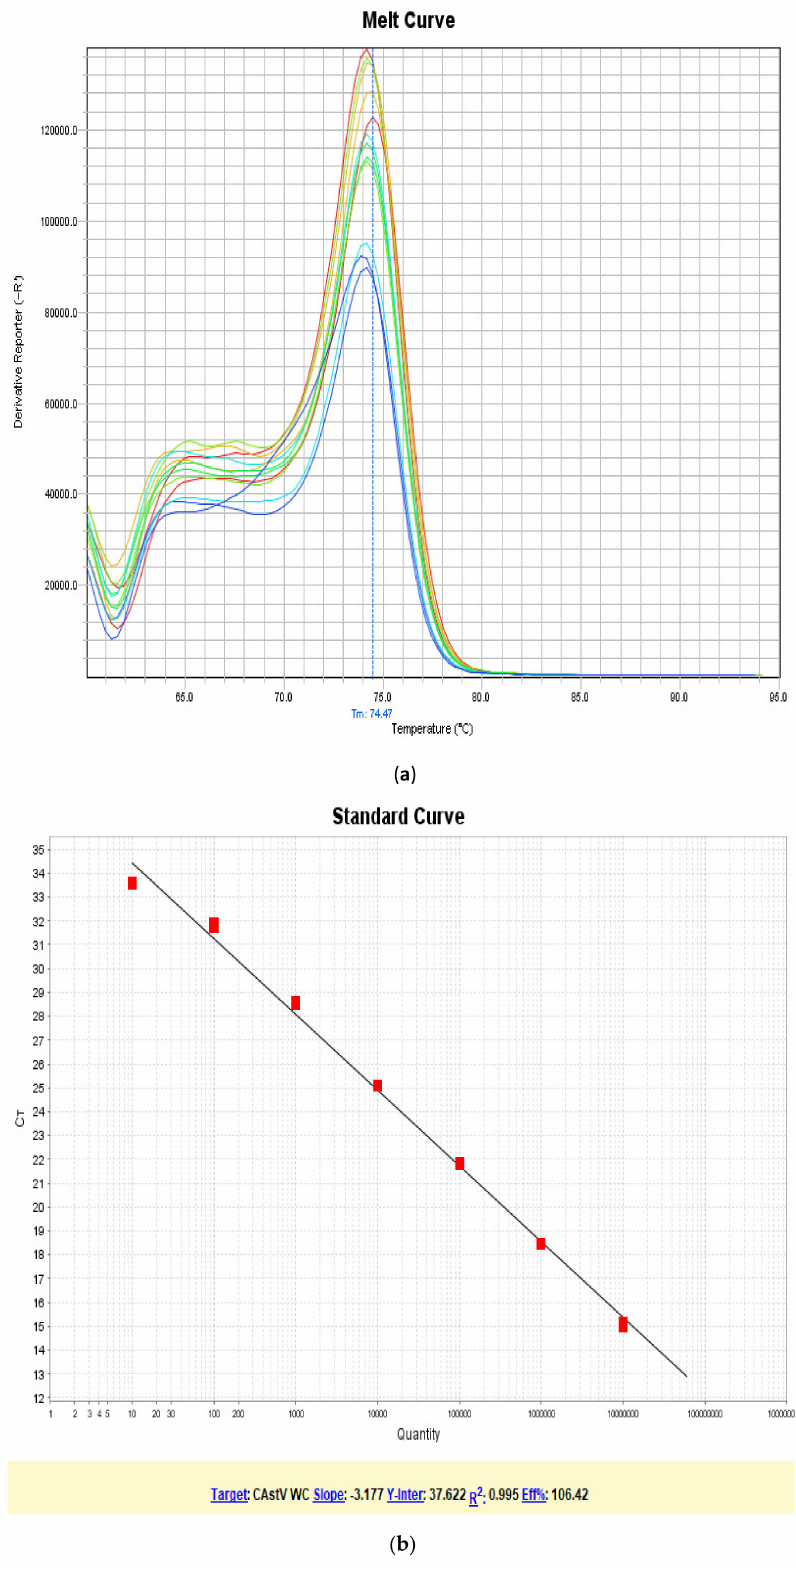
Figure 3. Melting ( a ) and e ffi ciency ( b ) curves of the RT-qPCR assay performed to amplify and quantify CAstV associated with WCS. The melting curve showed a melting temperature of 74.47 ◦ C, and the standard curve had an e ffi ciency of